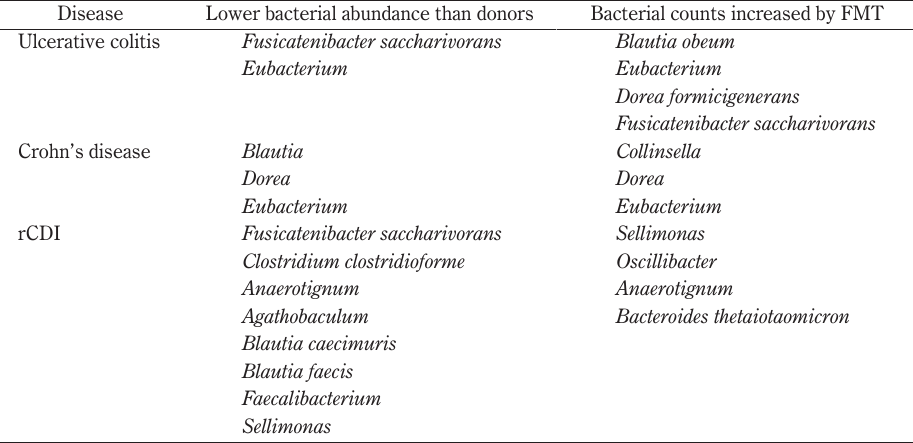
Table 4 Summary of the gut microbial characteristics of each disease Disease Lower bacterial abundance than